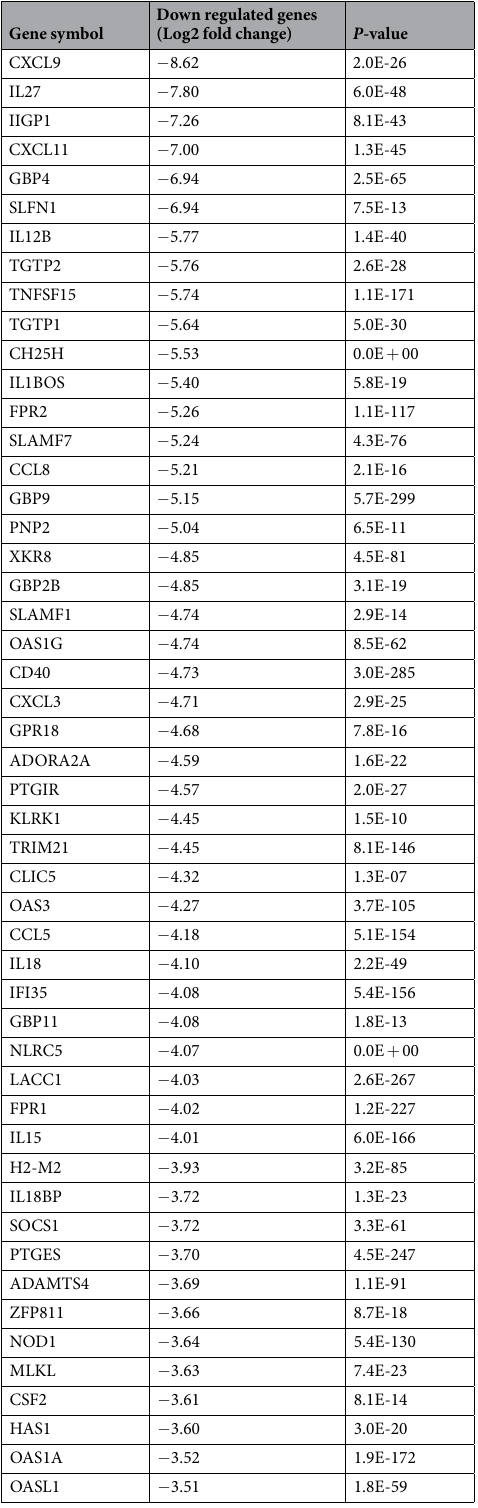
Table 1. Top 50 GSK-J4 down-regulated unique genes in LPS treated